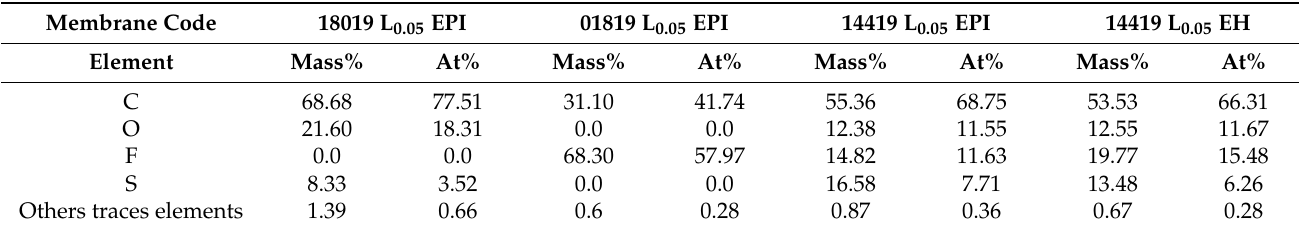
Table 3. Elemental composition of selected prepared pure polymer and blend membranes. Membrane